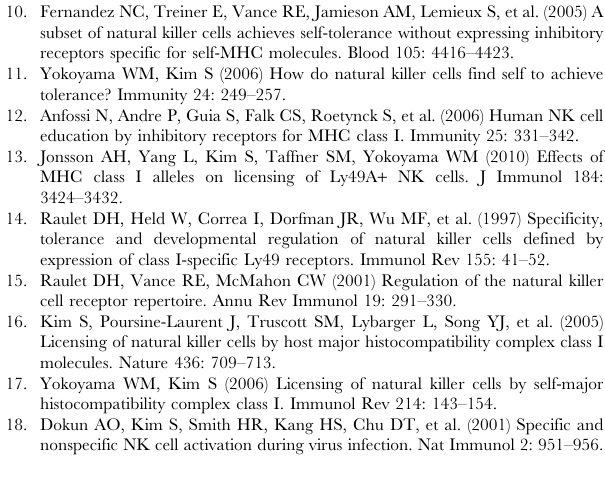
(LGL-1 and AT8 (data not shown)). This receptor is perfectly expressed in the B6. H2 0 parental strain (data not shown) and doesn’t seem to be correlated with a defect of NK maturation since the Killer cell lectin-like receptor G1 (KLRG1) is equally expressed between the Cmv3 FVB / H2 0 /Tg(D k ) + and the Cmv3 FVB / H2 0 /Tg(D k ) 2 mice. Figure S8 NK cell–dependent MCMV infection control in congenic and F3 mice. (A) Viral loads in spleens (top) and livers (bottom) 3 d post-infection in MCMV-resistant MA/My progen- itor, BALB- Cmv3 MA/My H2 k congenic, and Cmv3 FVB /H2 0 /Tg(D k ) + transgenic mice that were NK cell depleted (white squares) or not (black circles) with anti-asialo GM1 antibody. (B) Number of NK cells per spleen (top) and BrdU incorporation (bottom) at 7 d post- MCMV infection in MCMV-resistant mice of the indicated genotypes. For the number of NK cells, data are presented as mean 6 SEM and statistically significant differences between groups are indicated. For BrdU incorporation data are represent- ed by fold increase between noninfected and infected animals. Results shown are representative of 1–2 experiments. Figure S9 Effect of Ly49-specifc monoclonal antibody depletion in MA/My mice during the course of MCMV infection. MCMV viral load was assessed in untreated MA/My mice (mock) or treated with the indicated monoclonal antibody prior to MCMV infection. Viral load in spleen was determined by plaque assay after 3 d of infection. Found at: doi:10.1371/journal.pgen.1001368.s009 (1.47 MB